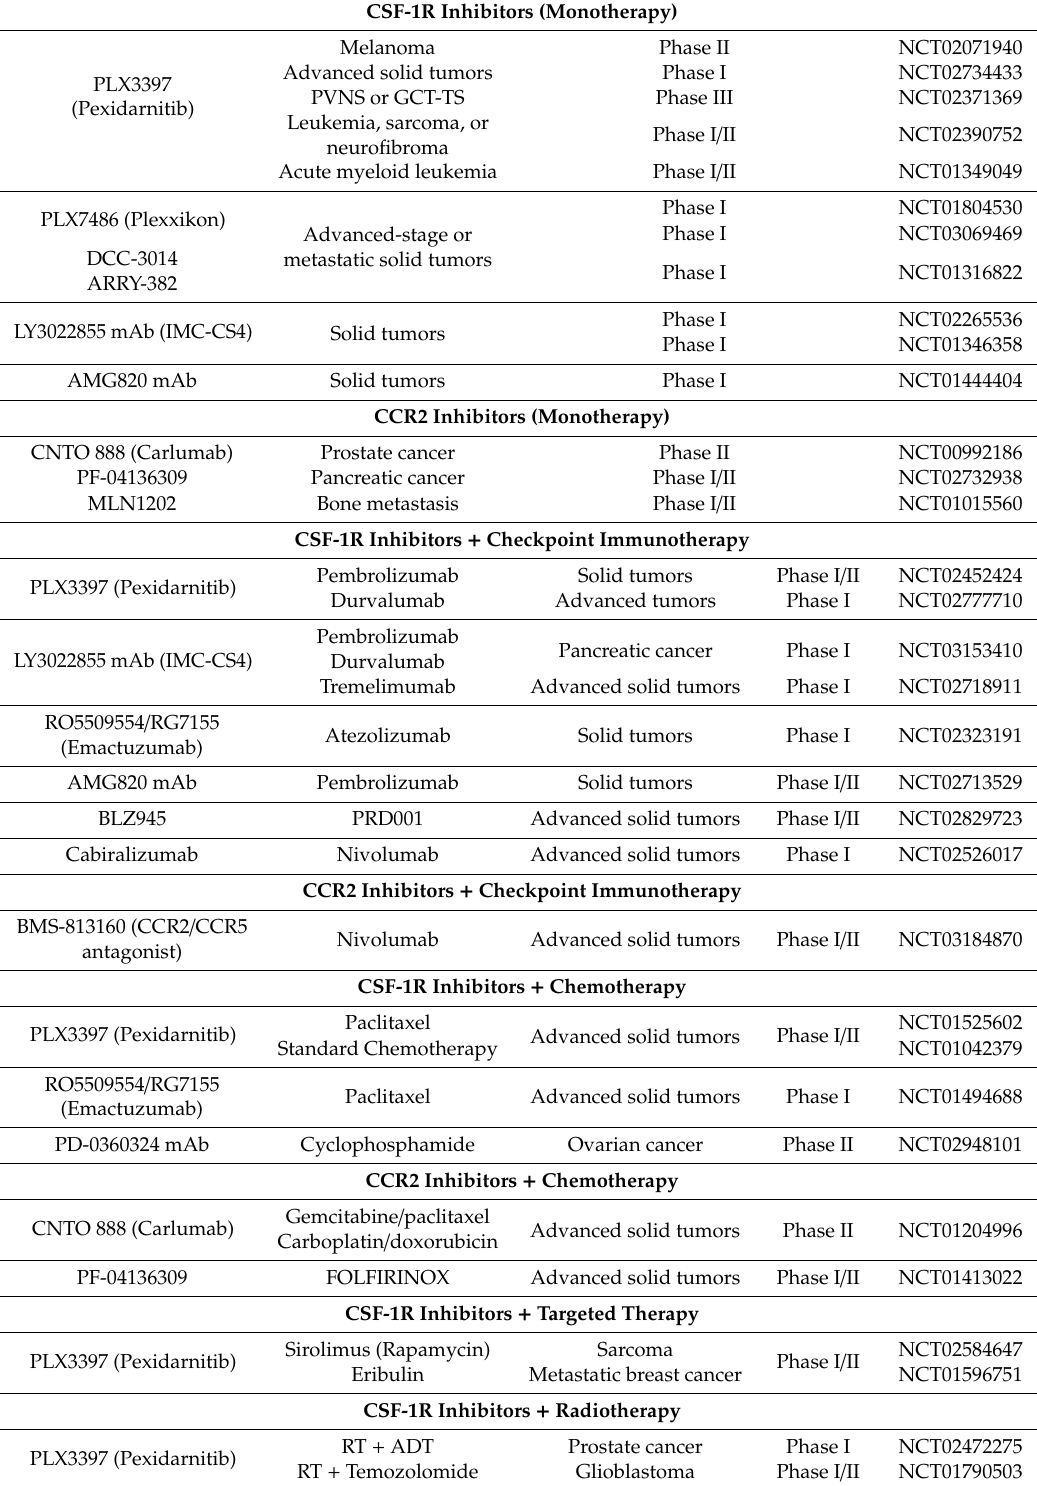
Table 1. Summary of clinical trials to inhibit the recruitment or to deplete TAMs, also in combination with other anti-tumor